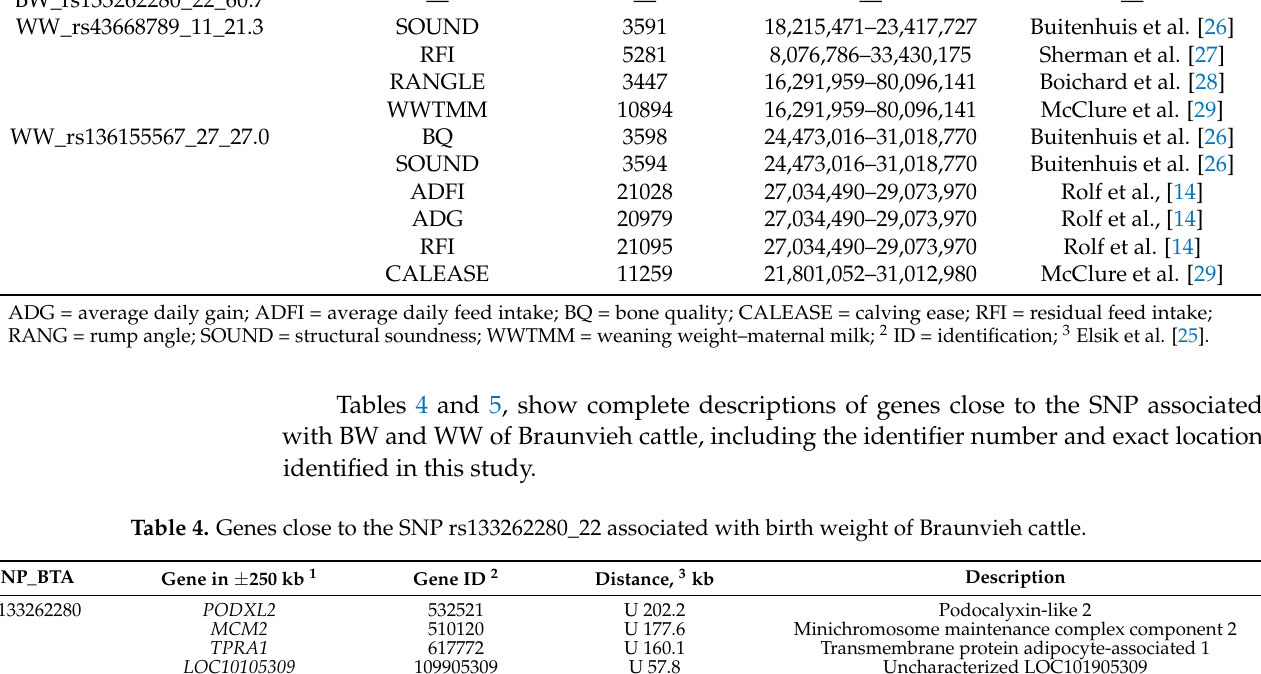
Table 5. Genes close to the SNPs associated to weaning weight of Braunvieh cattle. SNP_BTA Gene in ±250 kb 1